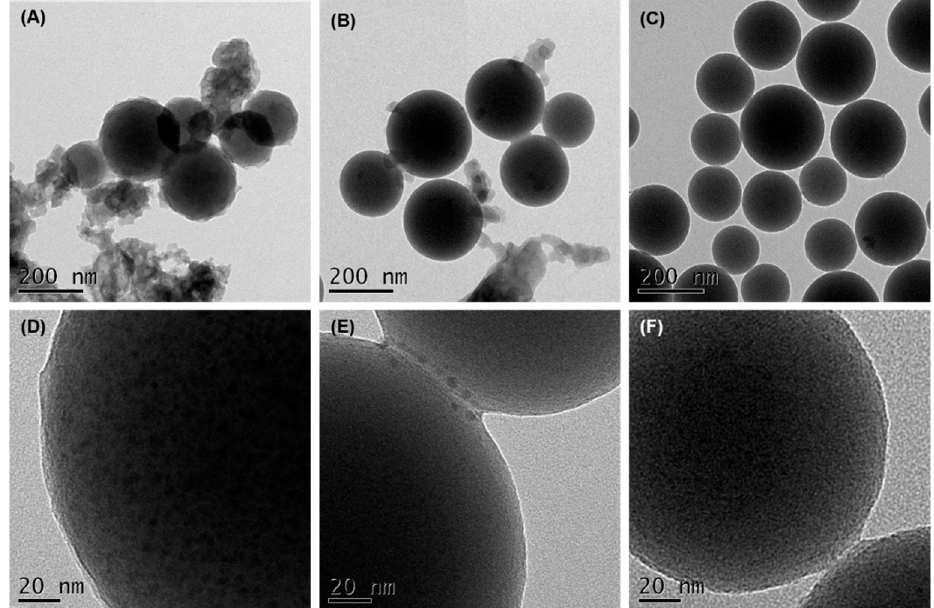
Figure 1 . TEM images with size distributions of the precursor and MOF ‐ CmS ( A , D, respectively); Figure 1. TEM images with size distributions of the precursor and MOF-CmS ( A , D , respectively); precursor and MOF ‐ CS ( B , E , respectively); CS ( C , F , respectively); among them, ( D , E , and F ) are precursor and MOF-CS ( B , E , respectively); CS ( C , F , respectively); among them, ( D – F ) are the enlarged the enlarged pictures of ( A , B, and C ), respectively. pictures of ( A – C ),